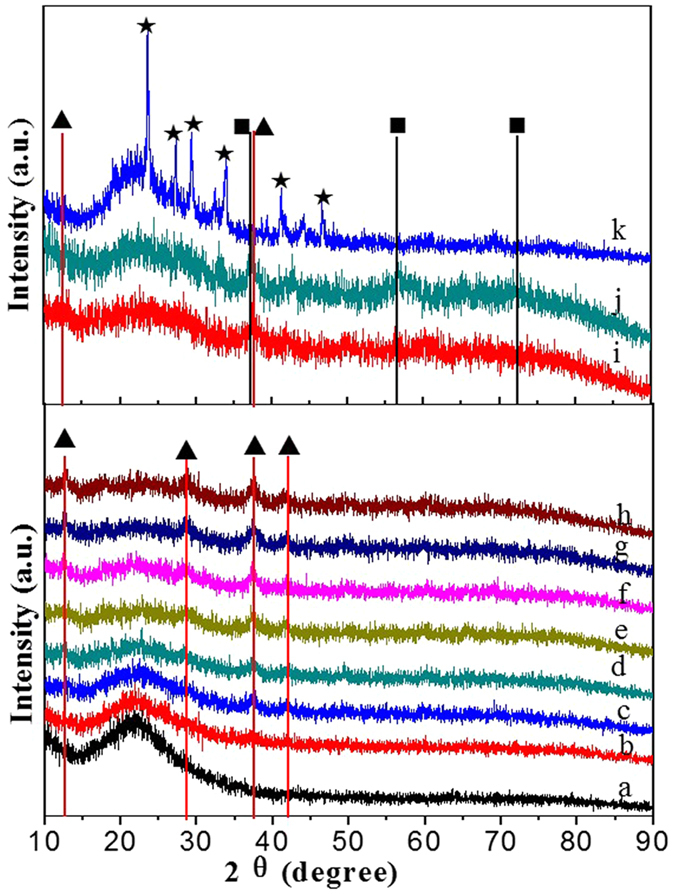
XRD patterns of as-prepared catalysts.SiO2 (a); K-OMS-2/SiO2-10 (b); K-OMS-2/SiO2-20 (c); K-OMS-2/SiO2-30 (d); K-OMS-2/SiO2-40 (e); K-OMS-2/SiO2-50 (f); K-OMS-2/SiO2-60 (g); K-OMS-2/SiO2-70 (h); K-OMS-2/Silica gel-50 (i); MnOx/SiO2-50 (j); KNO3/SiO2-50 (k).